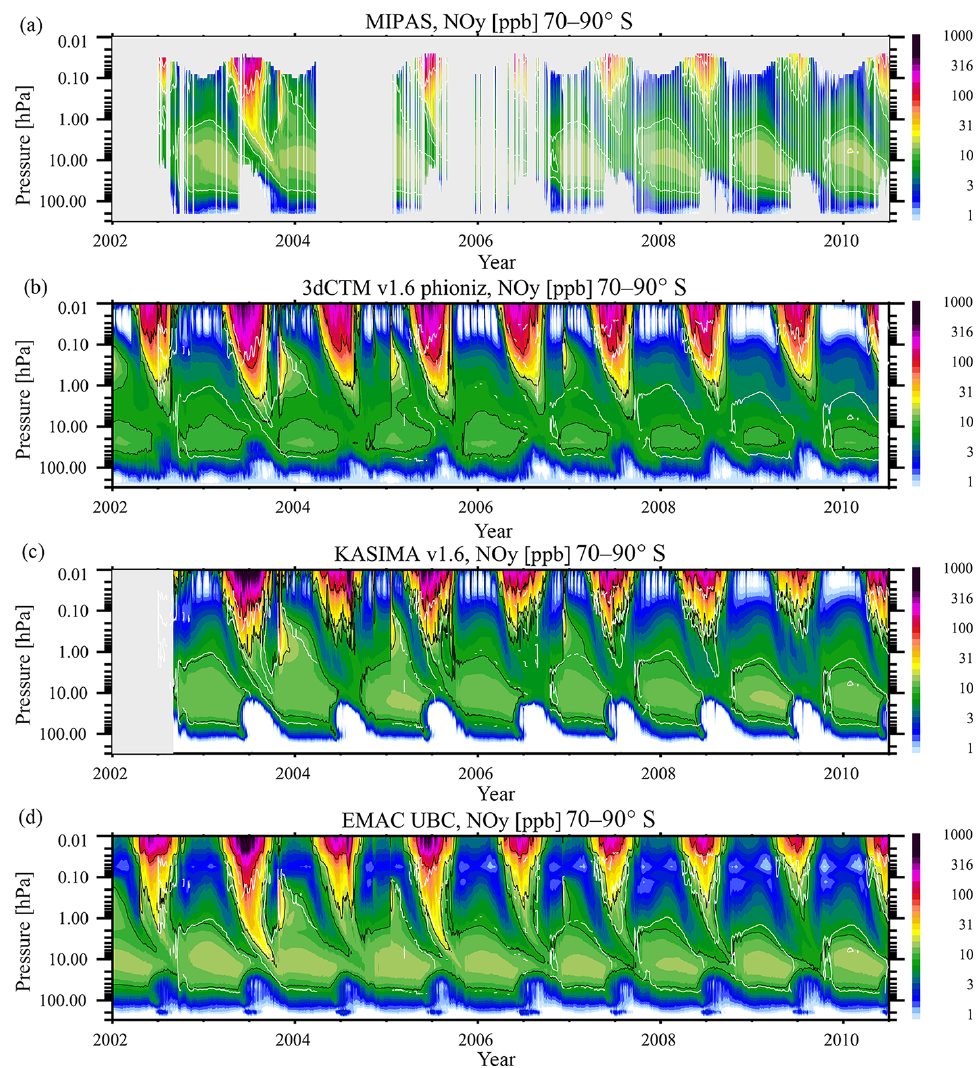
Figure 3. Southern Hemisphere temporal evolution of the volume mixing ratio of NO y in all three models and MIPAS measurements in the full common altitude range. (a) MIPAS, (b) 3dCTM, (c) KASIMA, and (d) EMAC. The white contour lines refer to the respective MIPAS values (at 10, 20, 100, and 1000ppb) smoothed over 7 days for clarity. In black are the respective model contours (not smoothed). The gray shaded areas in the first panel are periods without MIPAS data, and in the third panel, periods before the start of the KASIMA model run.